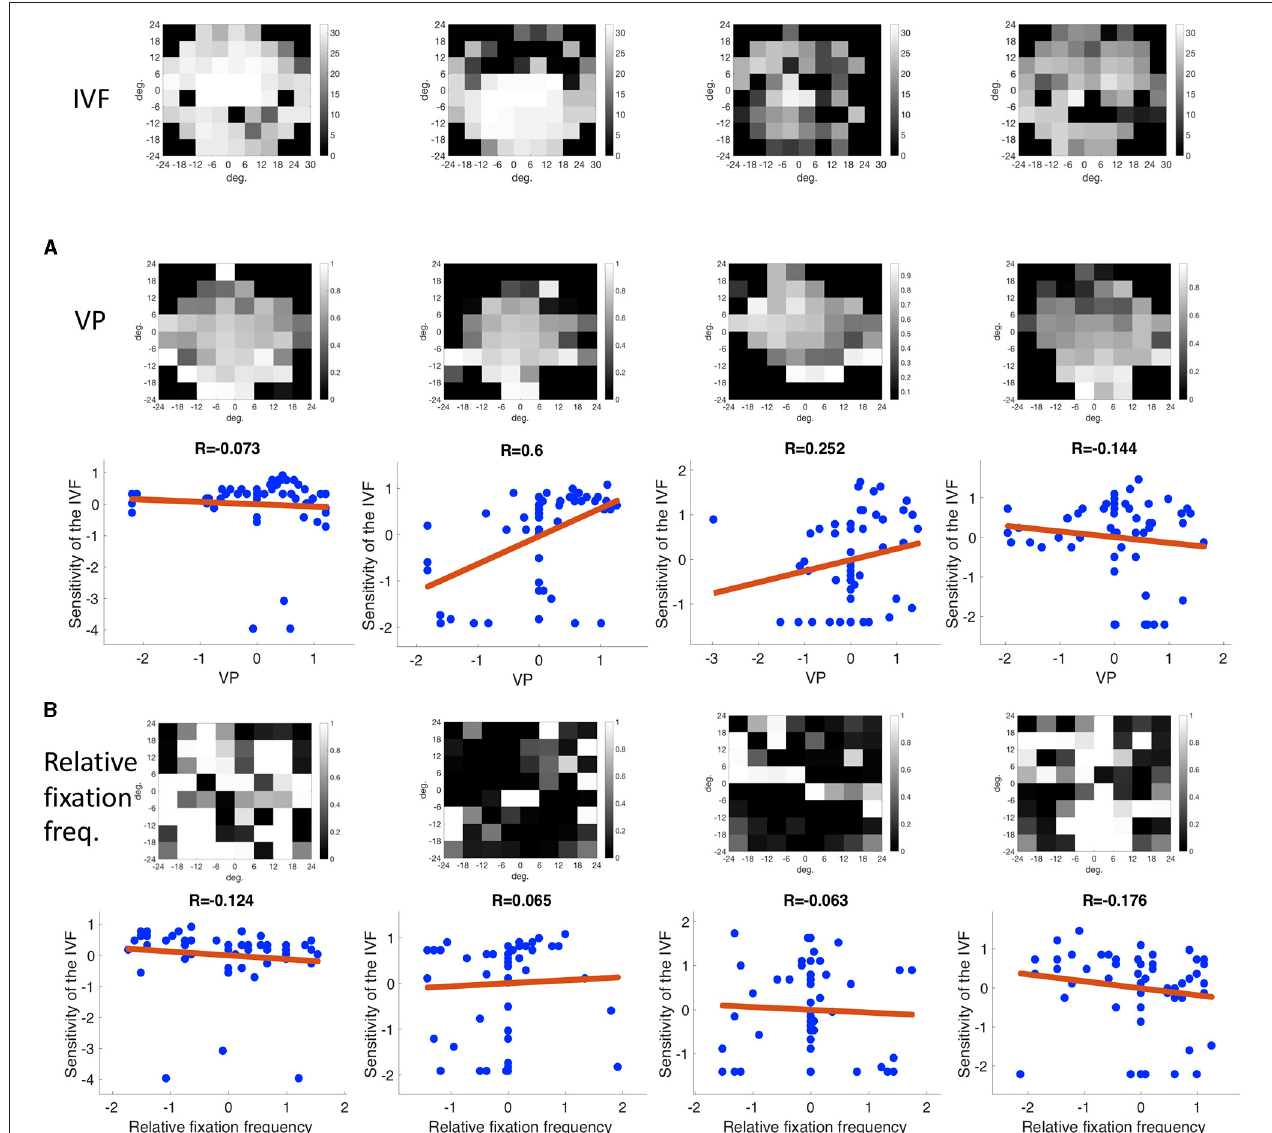
FIGURE 15 | Representative examples of (A) the correlation of the VP and the sensitivity of the IVF and (B) the correlation of the relative fixation frequency and the sensitivity of the IVF. The discrete locations in which the VP and relative fixation frequency were binned matched the 24-2 SITA test locations of the HFA. Both panels show the same patients. Their IVF is shown in the top row. Neither the VP nor the relative fixation frequency is consistently correlated with the IVF over all patients.